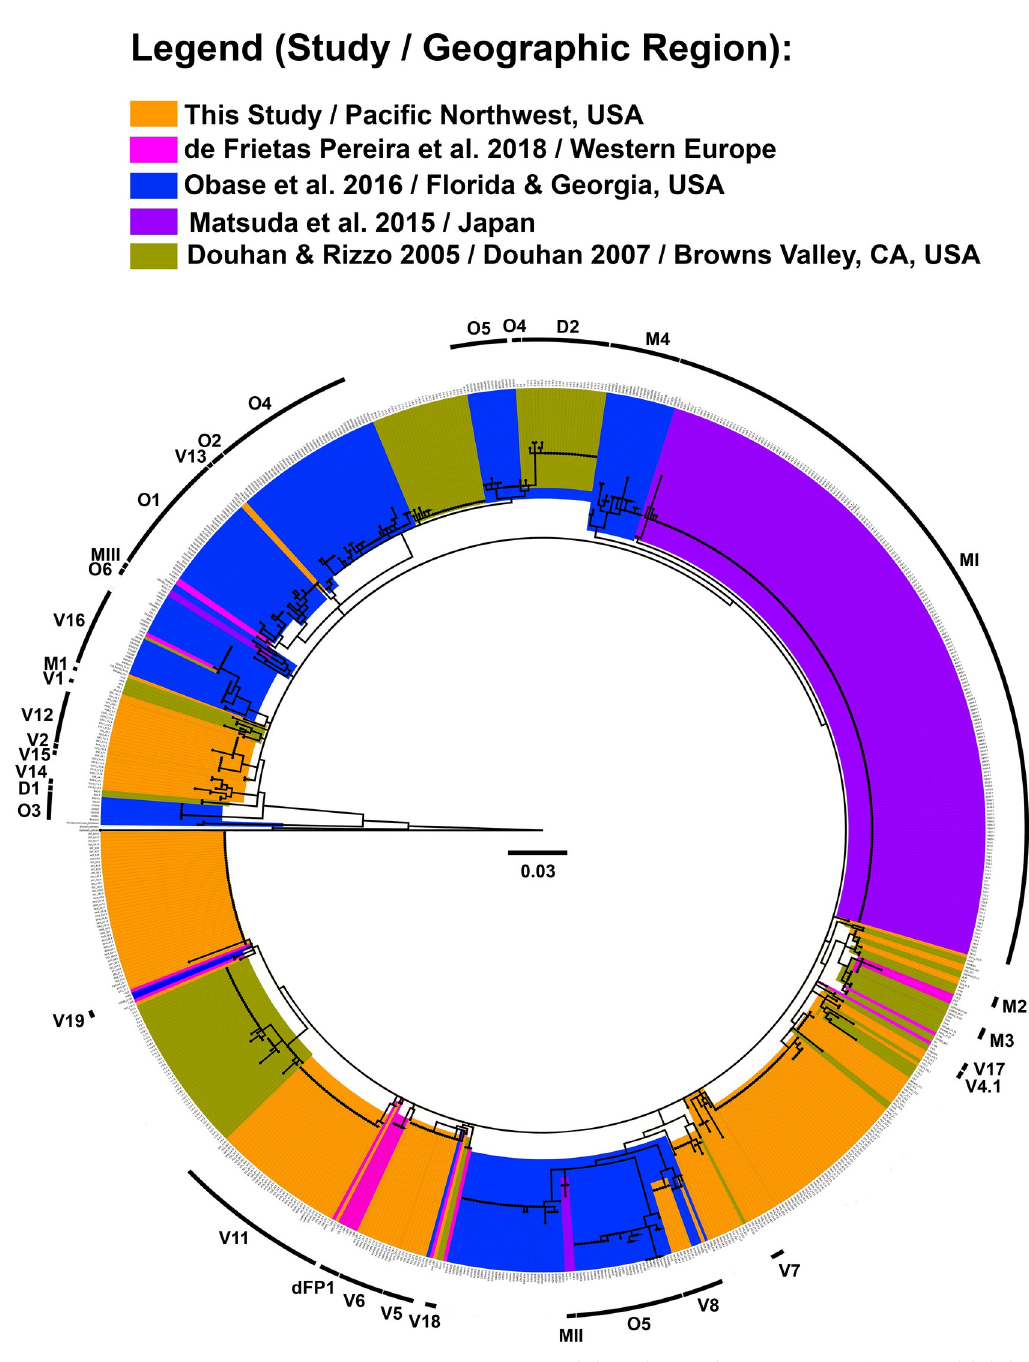
Fig 4. Global isolate collection GAPDH RAxML phylogenetic tree. Clades with strong bootstrap support ( > 80%) are labeled on the outer ring. Strongly supported clades implicated in this study are highlighted in orange and designated with V. Clades V16-V19 represent newly designated clades within the global C . geophilum isolate collection. The PNW isolates are highlighted in orange. Isolates are highlighted per the most recent published study of origin as follows: D [15,35] highlighted in gold; dFP [24] highlighted in pink; M [26] highlighted in purple; and O [25] highlighted in blue.